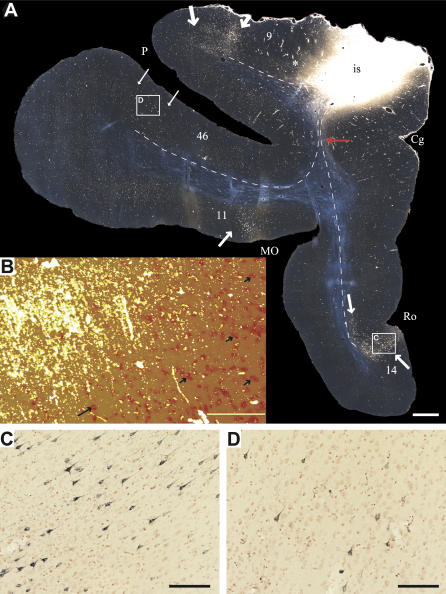
Example of Three Types of Trajectories Linking Prefrontal Cortices(A) Low-power darkfield photomicrograph of a coronal section through a middle level of the prefrontal cortex of a rhesus monkey brain showing an injection of HRP-WGA in area 9 (white area, “is”). Several projection sites can be seen (arrows). One projection with many labeled neurons is seen in the adjacent part of lateral area 9 (top, thick arrows); another projection is seen inferiorly in area 14 (medium arrows); a light projection is found in ventral area 46 below the principal sulcus (thin arrows), and another projection is seen in area 11. The dashed lines drawn in the white matter (appearing blue in darkfied) represent the shortest possible trajectory of axons in three of the projection sites. Axons linking lateral area 9 with the injection site (top) can take a fairly straight course. Labeled axons leaving the injection site are visible at this level (pink fibers in white matter), and some cross directly through layer VI (star). Axons linking area 14 with the injection site take a mildly deflected course through the white matter. Some labeled axons are seen exiting the injection site (pink fibers in white matter, below the depths of the cingulate [Cg] sulcus), and course inferiorly along the retrograde transport route to projection neurons. Axons linking ventral area 46 with the injection site travel below the principal sulcus (which is deep at this level) and must take a curved course.(B) High magnification of a site from an adjacent section to the one depicted in (A), showing that some axons (gold) coursing below the injection site take a straight course through the deep layers of the cingulate cortex. The approximate limit of the white matter is denoted by the large arrow (bottom left). The tissue was photographed under dark field illumination to show labeled axons in the white matter (gold, to the left of the large arrow), as well as axons coursing among neurons (red, some indicated by arrows), photographed under bright field illumination. The two photographs were merged.(C) Higher magnification of the mildly deflected projection in area 14 (from boxed area C in [A]) showing labeled neurons under brightfield illumination (blue pyramids). The labeled neurons at the top are in layer III, the ones at the bottom left corner are in layer V.(D) Higher magnification of the curved projection from ventral area 46 (boxed area D from [A]), shows a few labeled neurons in layer III (blue) under brightfield illumination. The section was counterstained with neutral red.Scale bars: (A) = 1 mm; (B–D), 100 μm. Orientation axes: medial, to the right; dorsal, on top.Cg, cingulate; MO, medial orbital; P, principal; Ro, rostral.